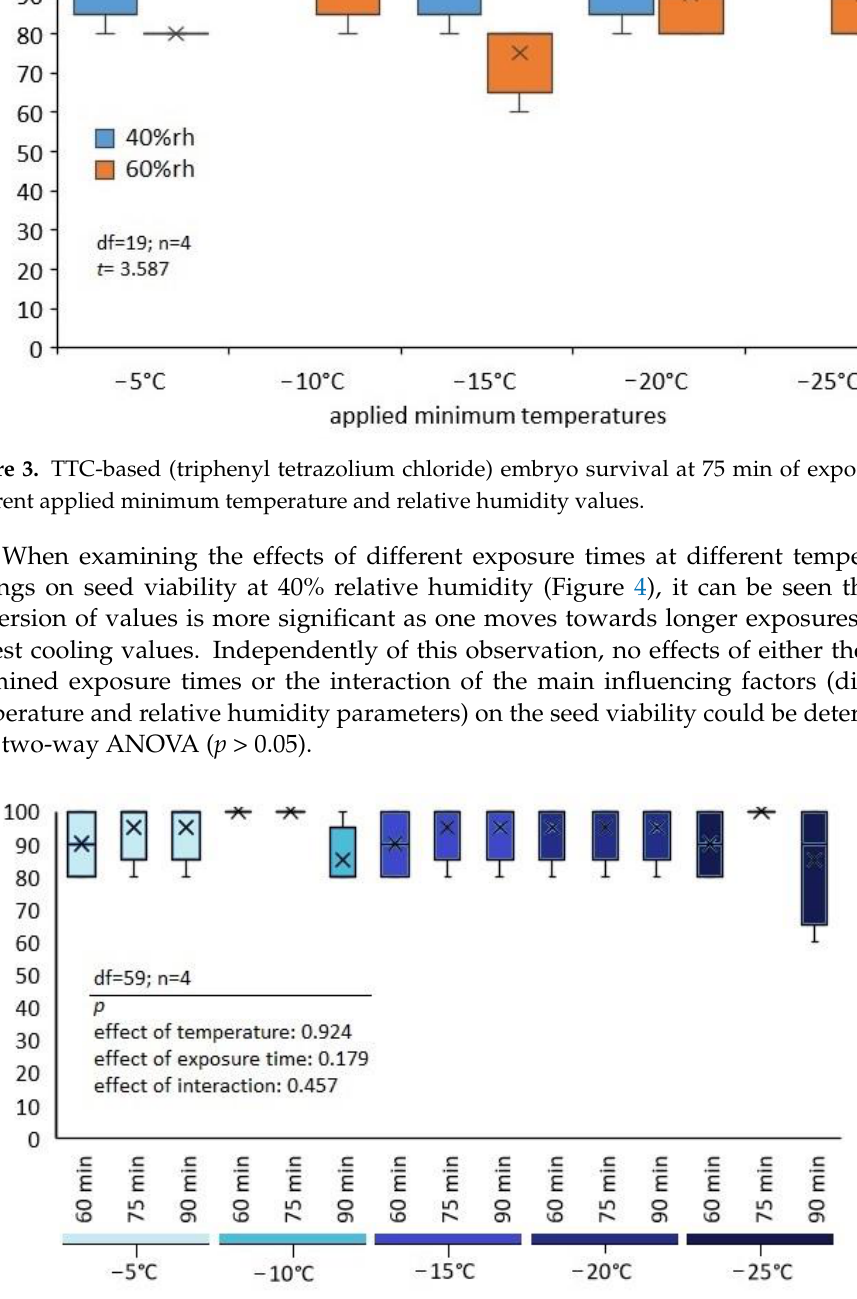
Figure 4. TTC-based embryo survival at 60, 75, and 90 min of exposure and 40% relative humidity at different applied minimum temperatures.